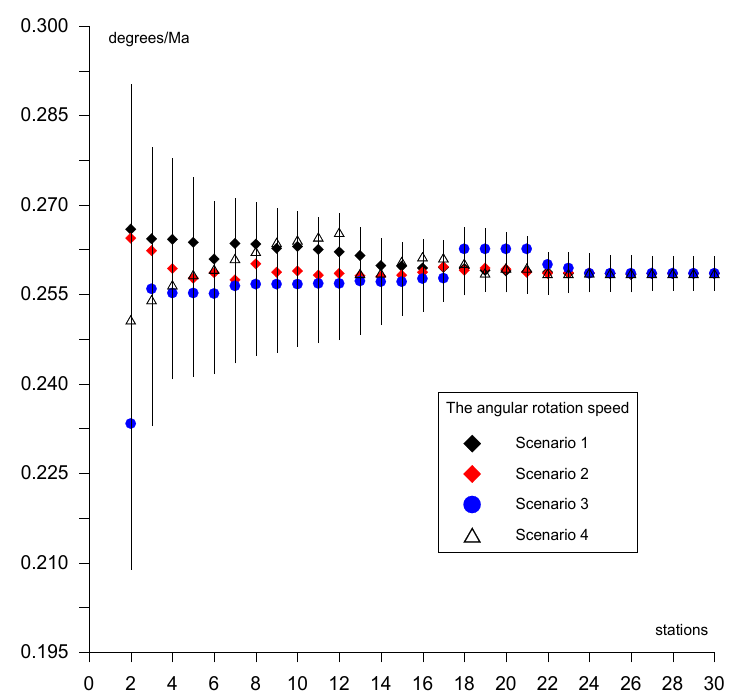
Figure 5. Results of the sequential solutions of the Λ parameter for four calculation scenarios.